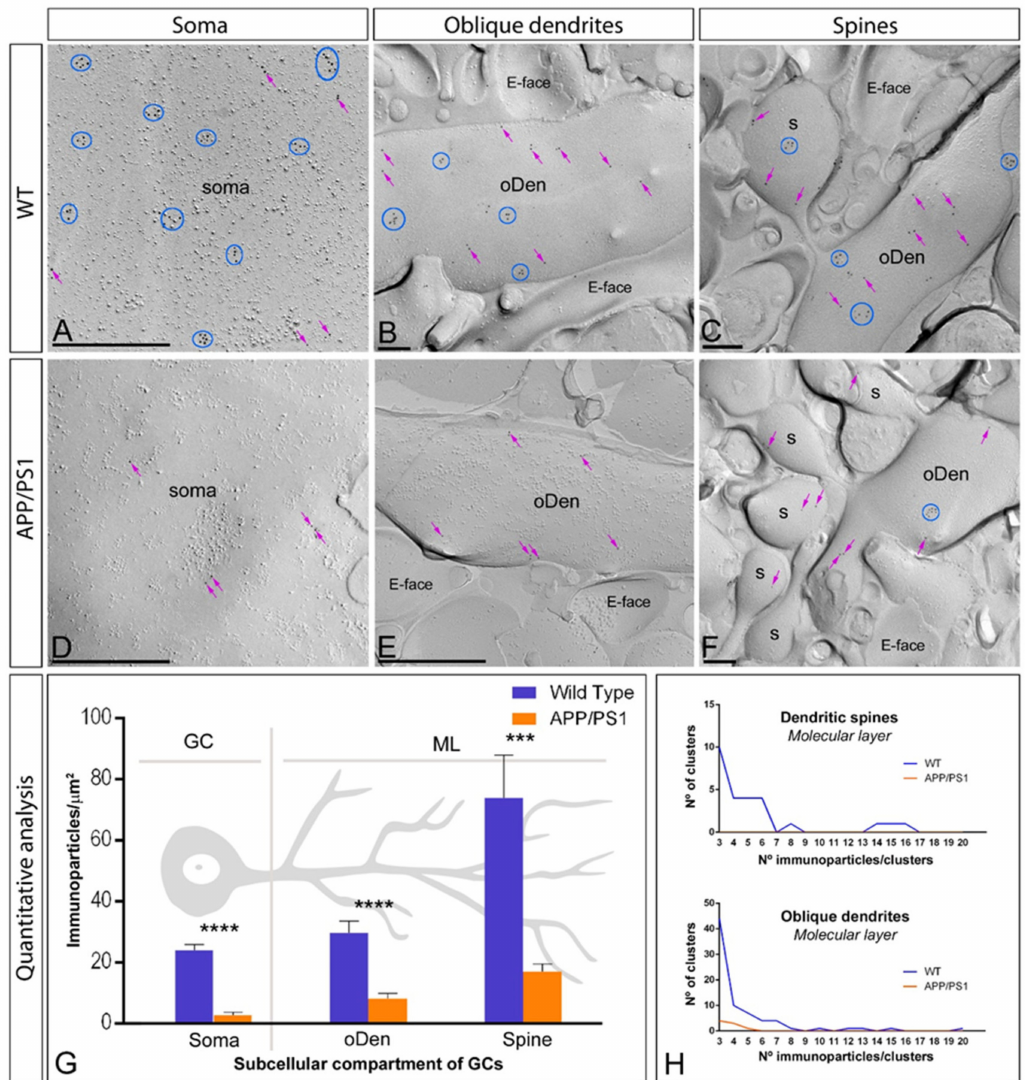
Figure 4. Subcellular localisation of mGlu 5 in somato-dendritic domains of DG granule cells in wild type and APP/PS1 mice. ( A – F ) Electron micrographs of the DG showing immunoparticles for mGlu 5 along the surface of granule cells, as detected using the SDS-FRL technique in wild type (panels A – C ) and APP/PS1 mice (panels D – F ) at 12 months of age. Immunoparticles for mGlu 5 were detected forming clusters (blue circles) or scattered (purple arrows) associated with the P-face in the soma, oblique dendrites (oDen) and dendritic spines (s) of granule cells cells. ( G ) Quantitative analysis showing that the density gradient of surface mGlu 5 immunoparticles was significantly reduced in the APP/PS1 mice compared to age-matched wild type controls in all strata and subcellular compartments analysed (Two-way ANOVA test and Bonferroni post hoc test, *** p < 0.001, **** p < 0.0001) (Table 1). Error bars indicate SEM. ( H ) Histograms showing composition of clusters in dendritic spines and oblique dendrites of granule cells. The composition of clusters was reduced in the APP/PS1 mice (1 cluster with 3 immunoparticles in spines; 8 clusters with a range of 3 to 5 immunoparticles in oblique dendrites) compared to age-matched wild type controls (26 clusters with a range of 3 to 16 immunoparticles in spines; 75 clusters with a range of 3 to 20 immunoparticles in oblique dendrites). Scale bars: ( A , D ), 0.5 µ m; ( B , C , E , F ), 0.2 µ